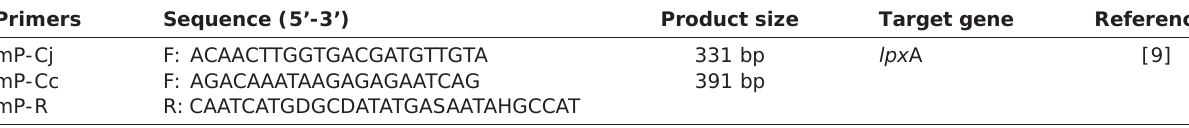
Table-1: Details of oligonucleotide primers used for mPCR. Primers